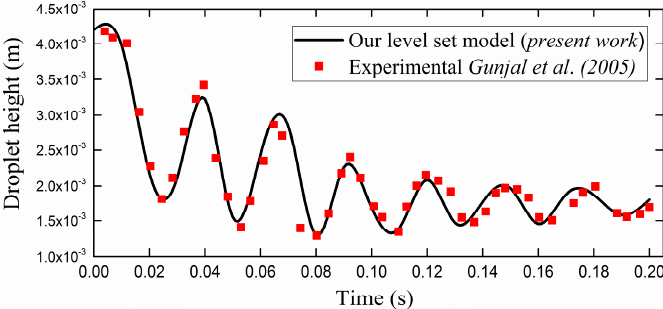
Figure 7. Comparisons between the heights of a 4.2 × 10 − 3 ‐ m ‐ diameter water droplet impacting onto a solid surface with a contact angle of 50° [49] (squares) and from the present model (curve).